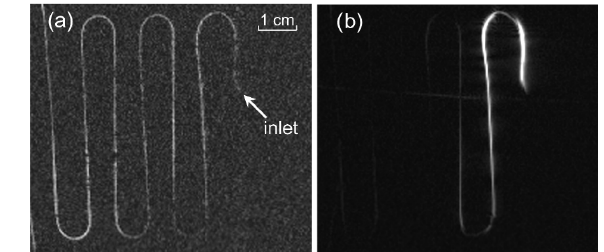
Figure 9. MRI image of TEMPOL aqueous solution flowing through the phantom. (a) Without microwaves, 3 acquisitions; (b) with microwaves, single acquisition. Phantom inlet position is indicated by the arrow. The radical concentration is 28mM and the flow rate is 2.5mLmin − 1